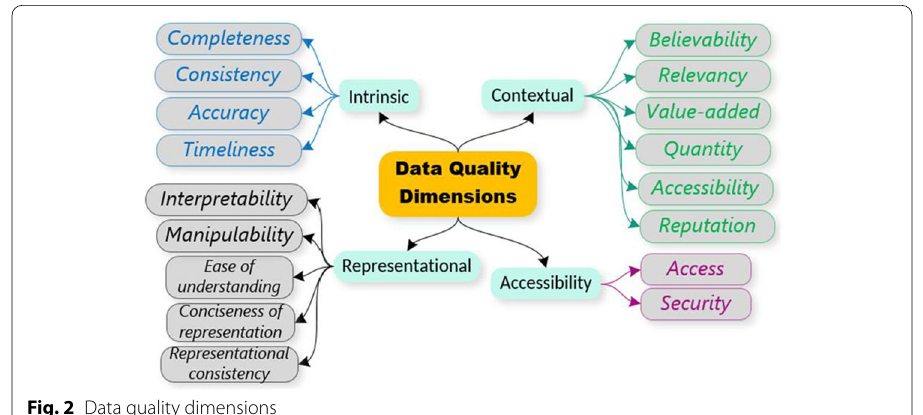
Fig. 2 Data quality dimensions